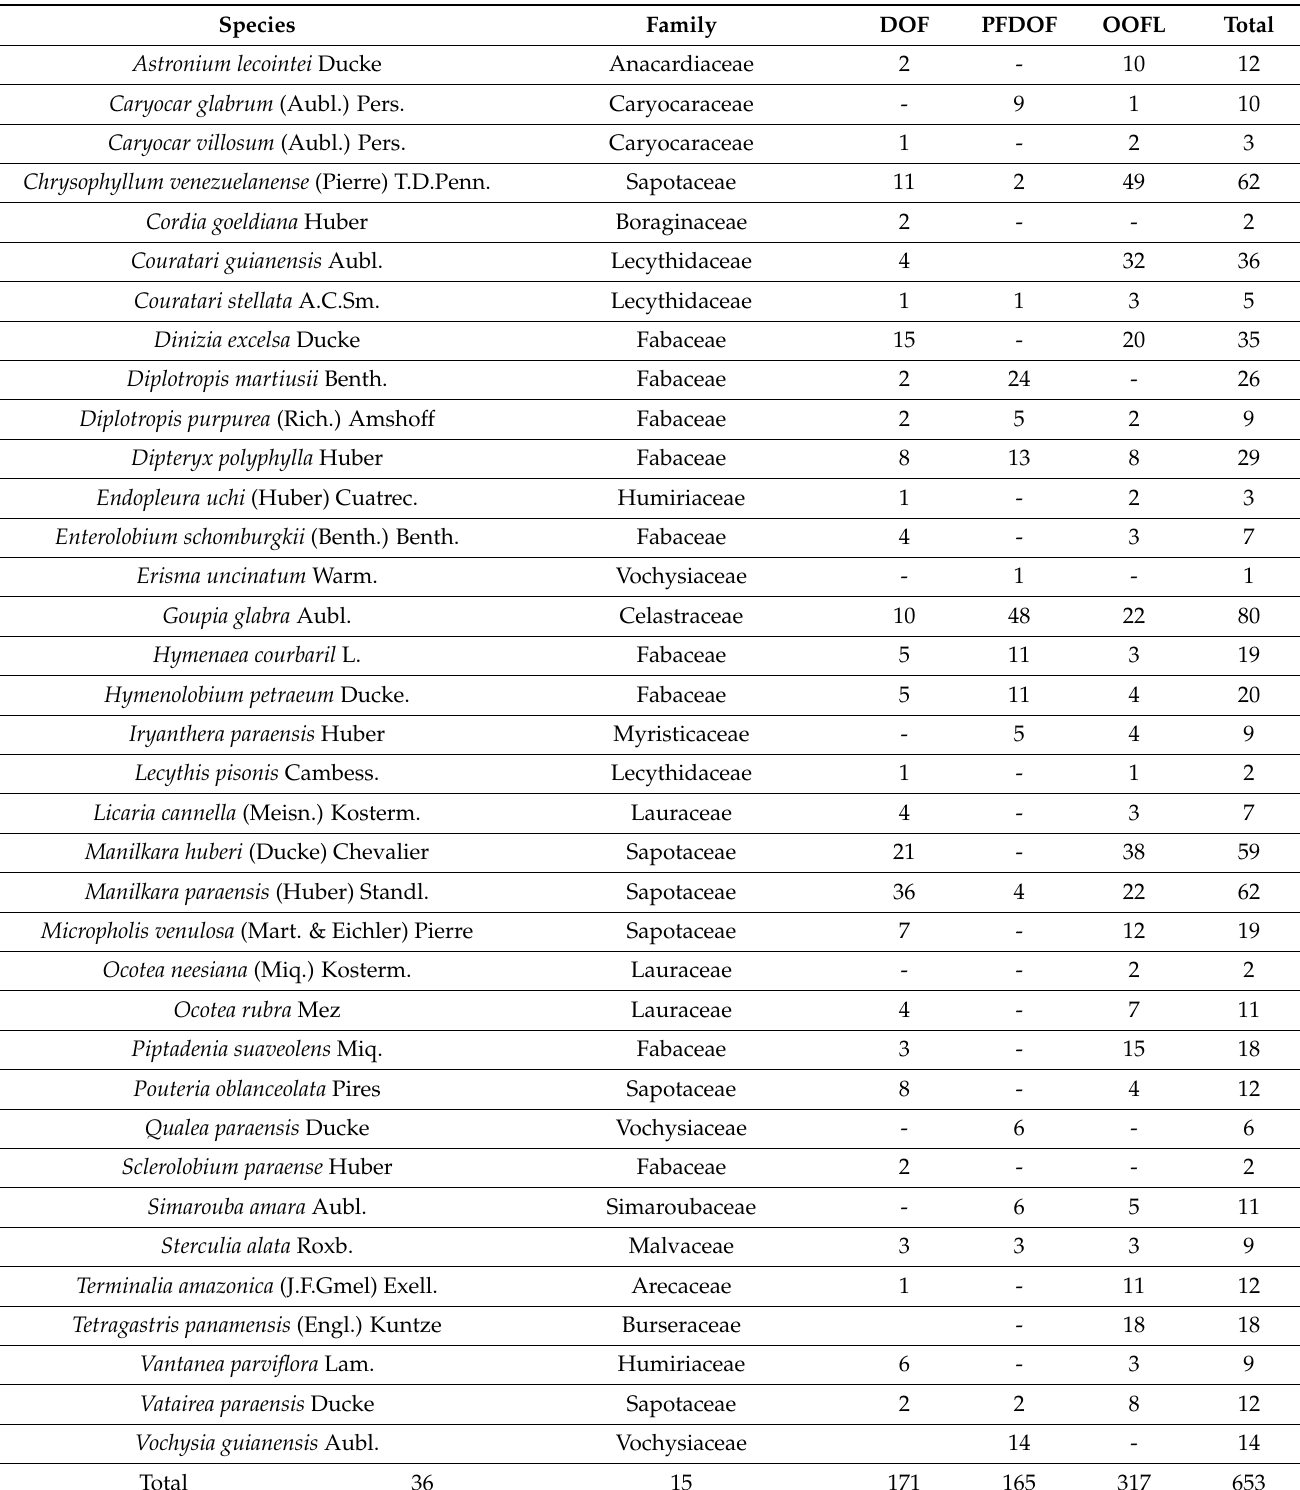
Table 4. Number of trees, arranged by species and phytophysiognomy, related to gap formation after extraction by reduced impact exploitation